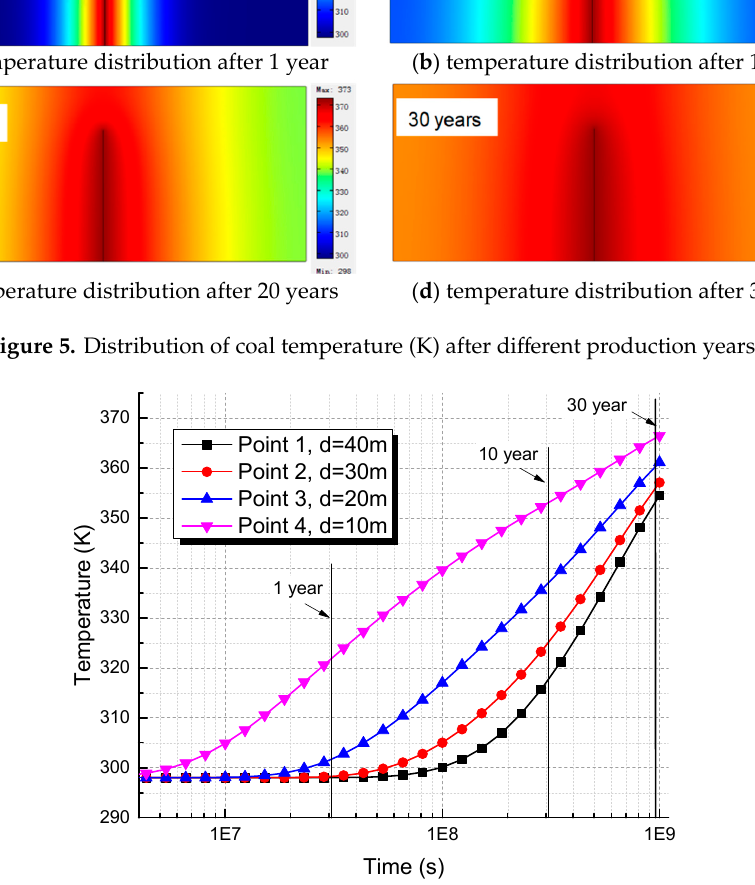
Figure 6. Evolution of reservoir temperature (K) at different observation sites.